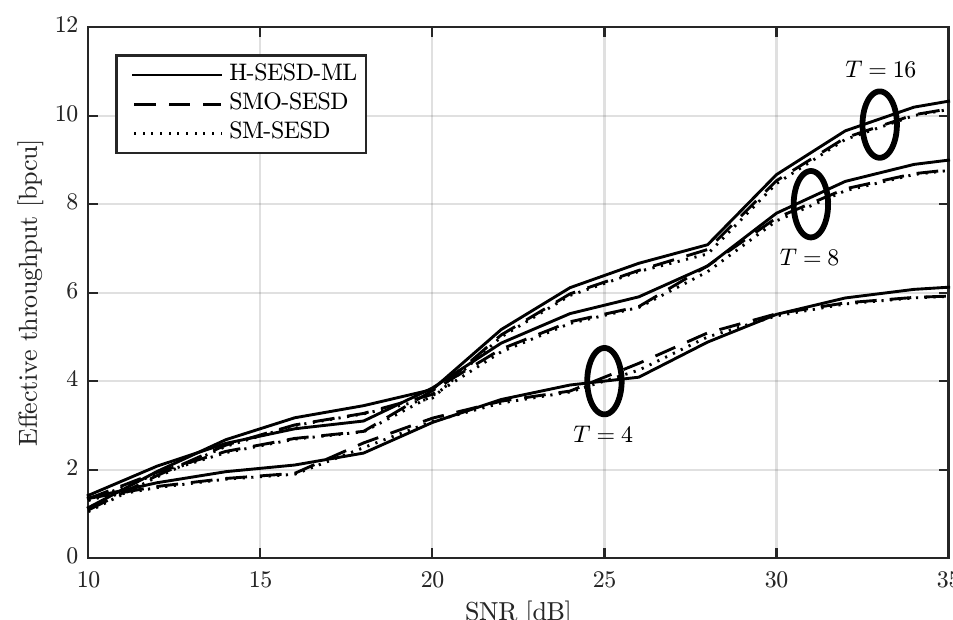
Figure 12. Effective throughput comparison of a PSAM constructed from rectangular QAM, its orthonormalization, and a constellation constructed using the hypercube method with the same QAM. This throughput is the maximum from that obtained with 4-QAM, 16-QAM and 64-QAM, and for M = N =